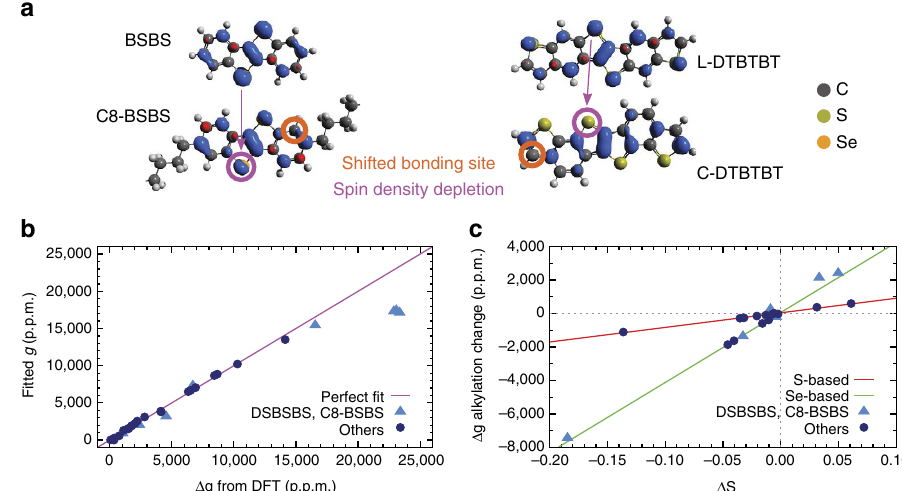
Figure 2 | Relationship between g-shift and atomic spin densities. ( a ) Spin isodensity contours of cationic (left) BSBS and C8-BSBS, and (right) L-DTBTBTand C-DTBTBTradicals. The C8-BSBS molecule shown has alkyl chains at the outer bonding site. Spin maxima and minima are shown in blue and red, respectively. The shifted bonding site at the phenyl rings has been labelled, and the observed spin depletion at heavy atoms highlighted. Note that only part of the alkyl chains in C8-BSBS are shown. ( b ) Correlation plot of D g OZ/SOC -terms calculated using DFT versus fitted on the form of equation 3. The outliers identified in the text are shown as light blue triangles, with the other numbers represented by dark blue circles. The magenta line y ¼ x represents a perfect fit. For brevity D g OZ/SOC has here been relabelled D g . ( c ) Plot of changes in D g OZ/SOC terms as a function of change of effective heavy atom spin upon alkylation of molecules (see text). Red and green lines represent linear fits to the sulfur- and selenium-based molecules,